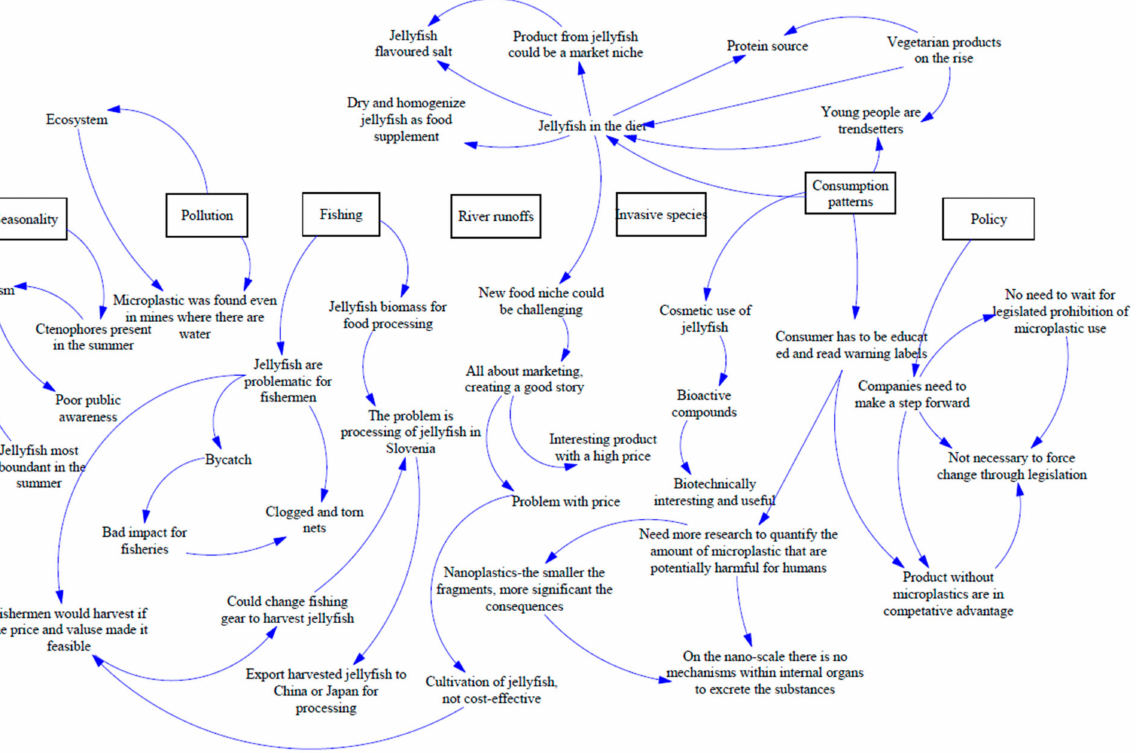
Figure 2. Vensim diagram of Slovenian mixed